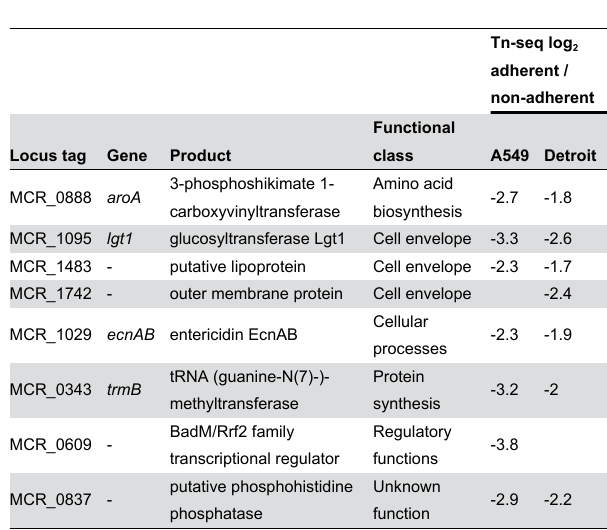
Table 1. Selection of Tn-seq identified genes required for adherence of M. catarrhalis